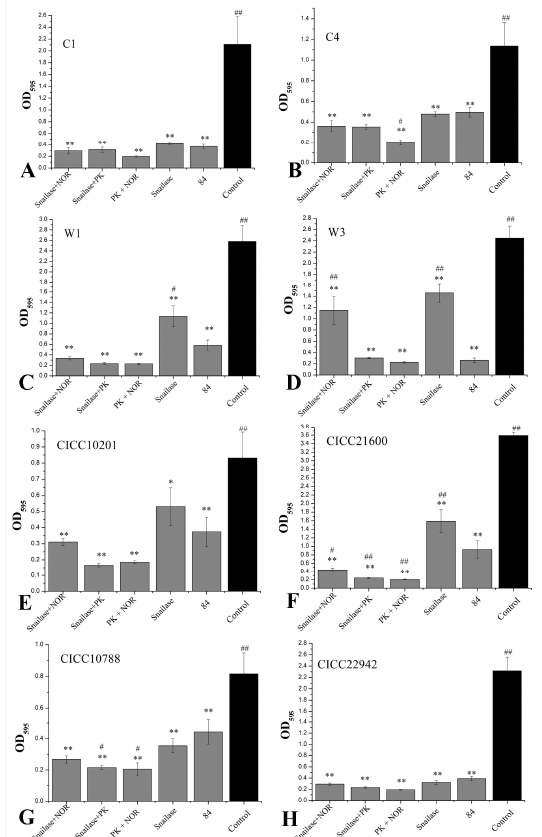
Figure 8. The enzymes mixture degraded Staphylococcus aureus biofilm. Note. OD 595 values of crystal violet retention were measured to determine biofilm formation. The biofilm of S. aureus C1 ( A ), S. aureus C4 ( B ), S. aureus W1 ( C ), S. aureus W3 ( D ), S. aureus CICC 10201 ( E ), S. aureus CICC 21600 ( F ), S. aureus CICC 10788 ( G ) and S. aureus CICC 22942 ( H ) was degraded by several reagents. PK: proteinase K, NOR: norfloxacin. The untreated biofilm of S. aureus was used as the control group. “*” means p < 0.05, “**” means p < 0.01, compared to control group. “ #” means p < 0.05, “ ##” means p < 0.01, compared to 84 disinfectant group. The values were means ± SD ( n = 6).